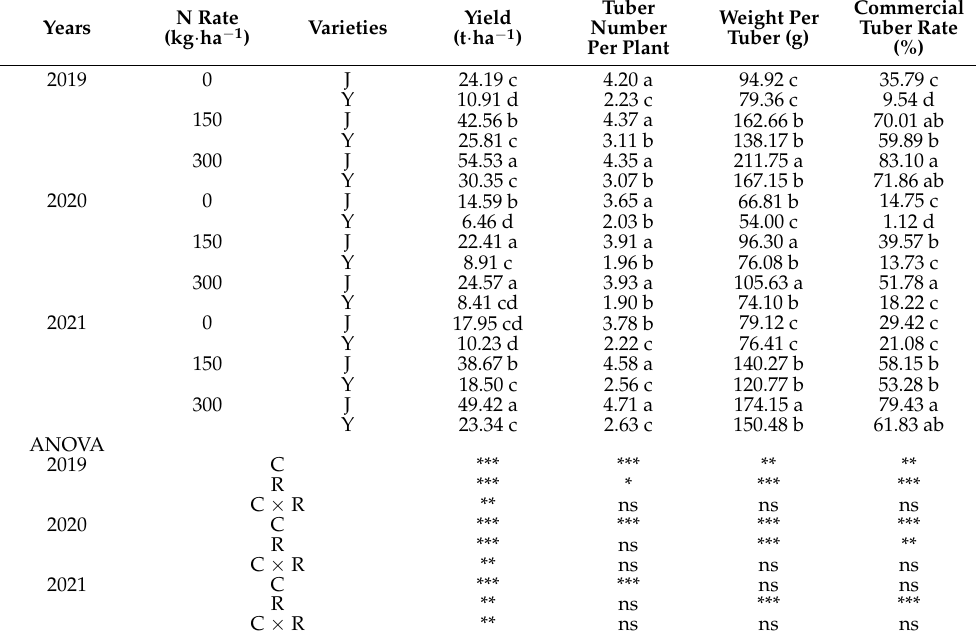
Different letters indicate multiple comparisons of an indicator between treatments in individual years, while having the same letter indicates a non-significant difference. Multiple comparisons of means were